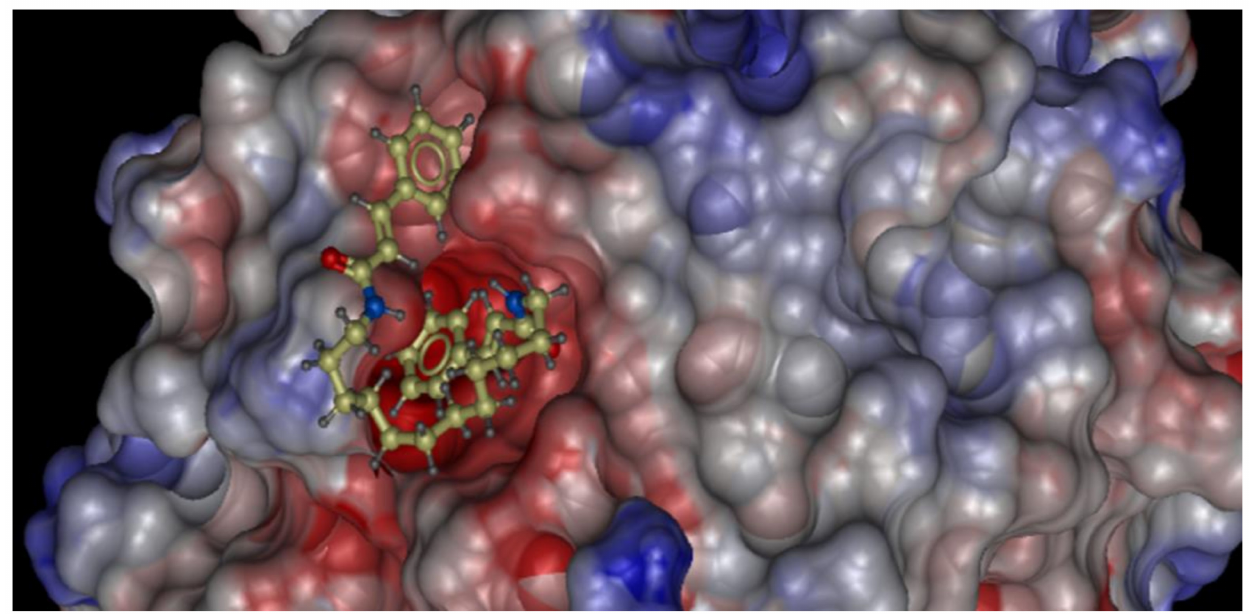
Figure 2. Molecular docking and binding mode of compound 2 to the druggable binding site of the APE/Ref-1 protein